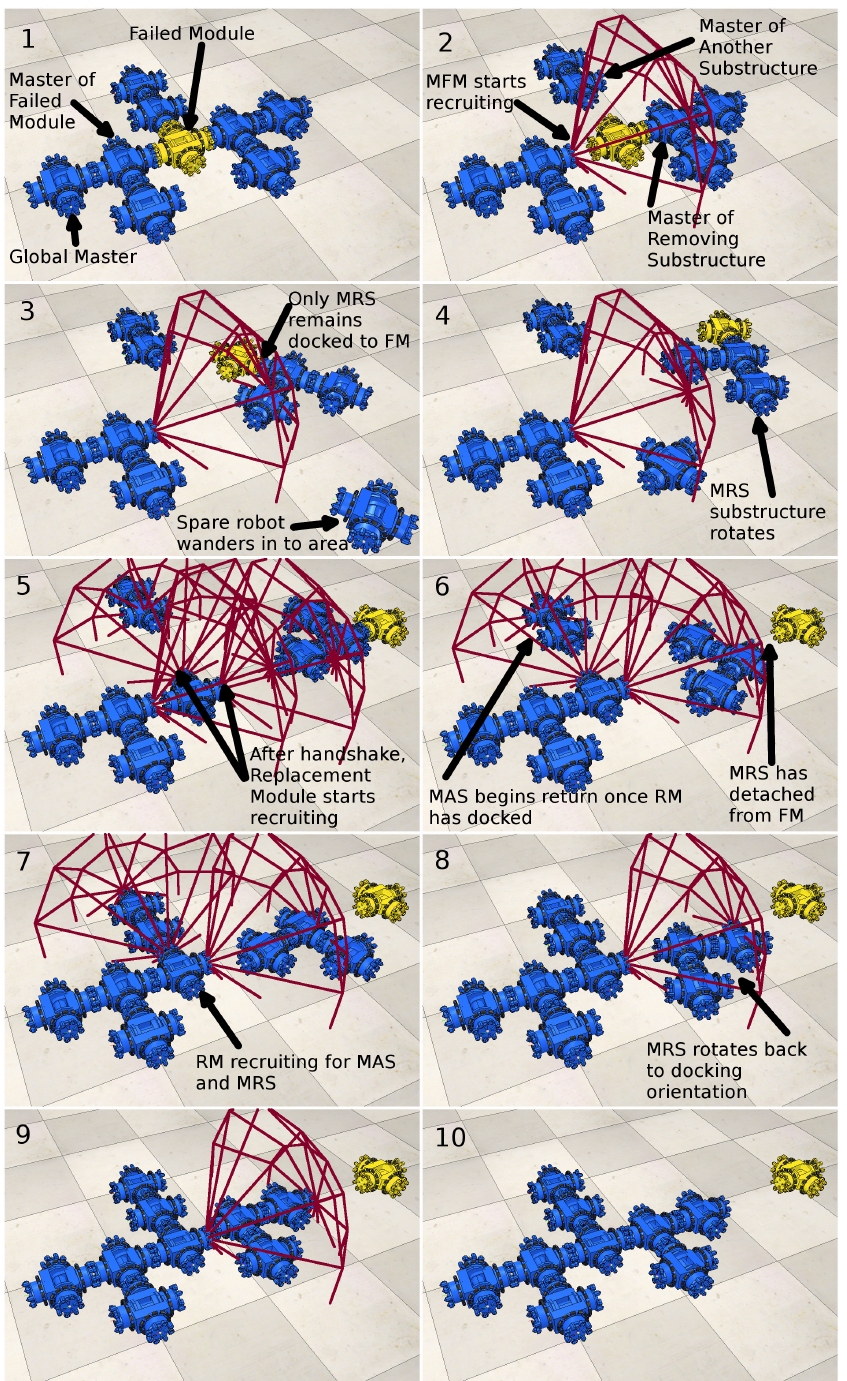
Figure 10. The concept of self-repair. Note how only the MFM, MRS, MAS and RM are involved in self-repair; robots not immediately neighbouring the failed module remain oblivious to the self-repair procedure and continue to act normally as slaves and/or